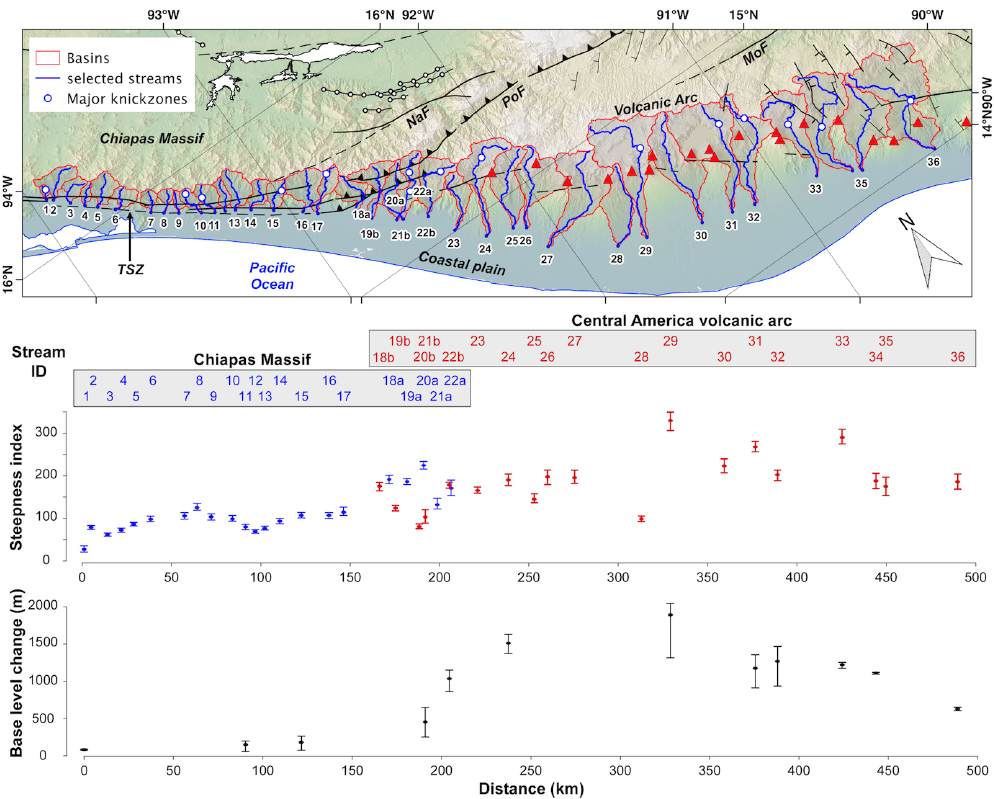
Figure 11. Analyzed streams in Chiapas Massif and Central American volcanic arc. Top: location map. Blue lines represent channels extracted from the modeled drainage network. White dots represent major knickzones. Red lines show limits of catchments. Black lines and red triangles represent main faults and active volcanoes, respectively. Bottom: plot of steepness index ( k sn ) values and estimated base-level changes along a profile passing through the outlet of each catchment. Abbreviations: MoF – Motagua Fault; NaF – Necta Fault; PoF – Polochic Fault; TSZ – Tonalá shear